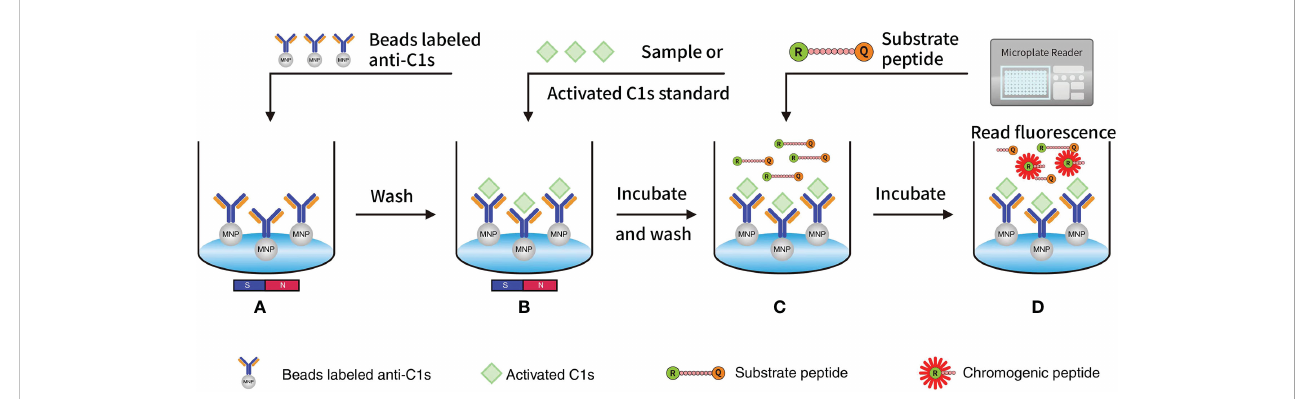
FIGURE 1 Quantitative FRET immunoassay of the activated C1s based on the capture of anti-C1s antibody: (A) MNP or Beads were precoated with antibody against activated C1s and then added into wells; (B) Activated C1s standard or samples were added and then speci fi cally combined with MNP-labelled anti-C1s antibody; (C) Substrate peptide was added and then cleaved by activated C1s; (D) Fluorescence intensity from Abz on the substrate fragment was monitored by a microplate reader, and the enzymatic ability of activated C1s was quantitatively analysed. Abz, ortho-aminobenzoic acid; MNP, magnetic nanoparticles; FRET, fl uorescence resonance energy